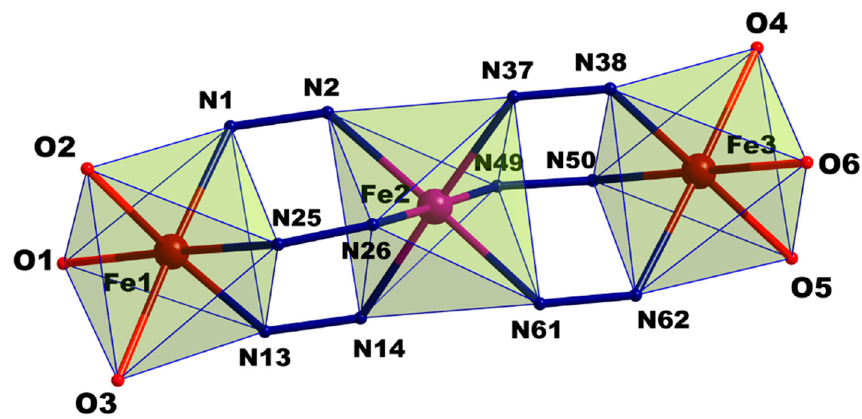
Figure 7. Labelled core of the linear trinuclear complex. Iron(II) sites (spheres) are coloured differently to distinguish the spin state (high spin (HS): red, low spin (LS): purple).